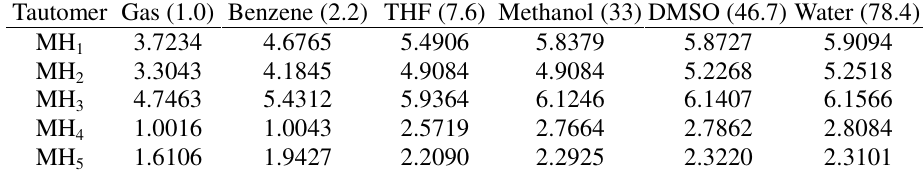
Table 3. Calculated dipole moments of optimized tautomers of maleic hydrazide